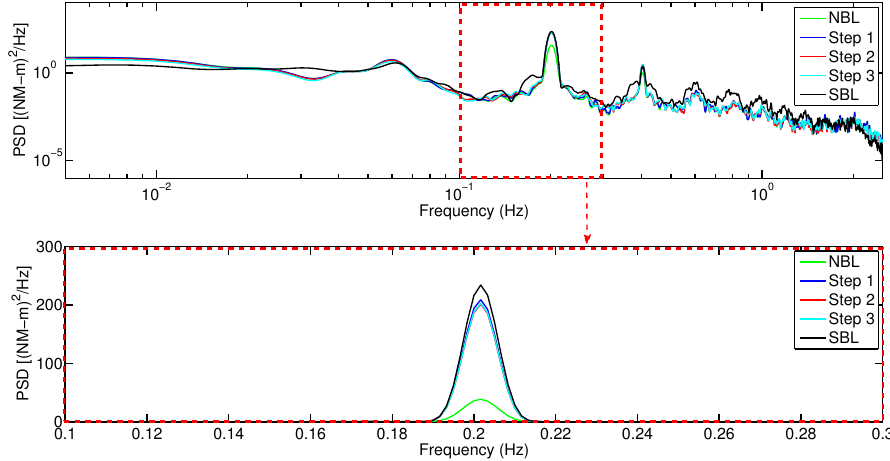
Figure 9. Comparison of OoPBM power spectra for a single case